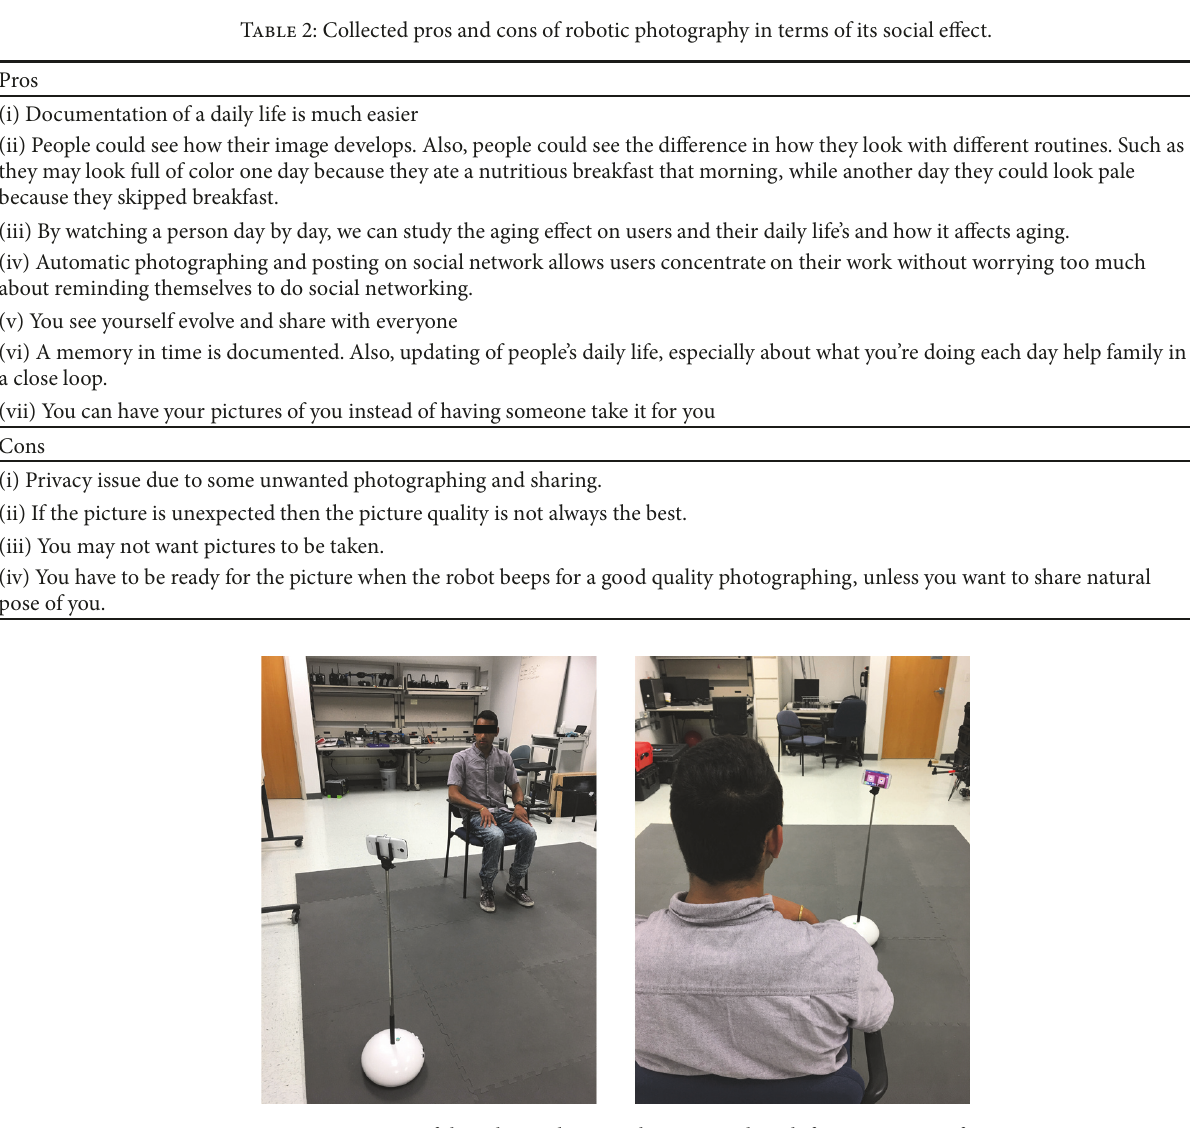
Figure 14: Experiment of the robotic photography using Dali with face recognition